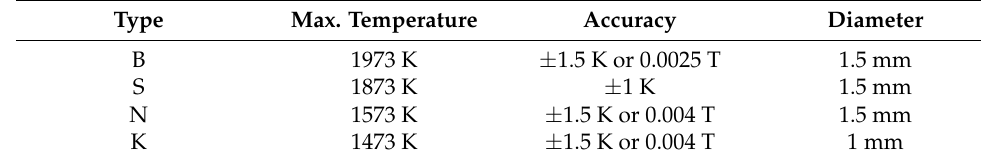
Table 2. Specifications of the different types of thermocouples used in the experiment [26]. Type Max. Temperature